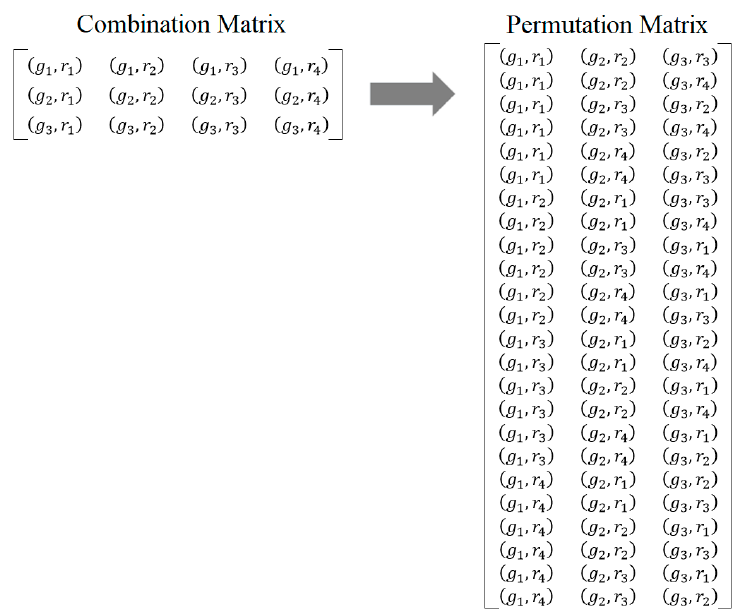
(cid:8) (cid:9) g 1 , g 2 , g 3